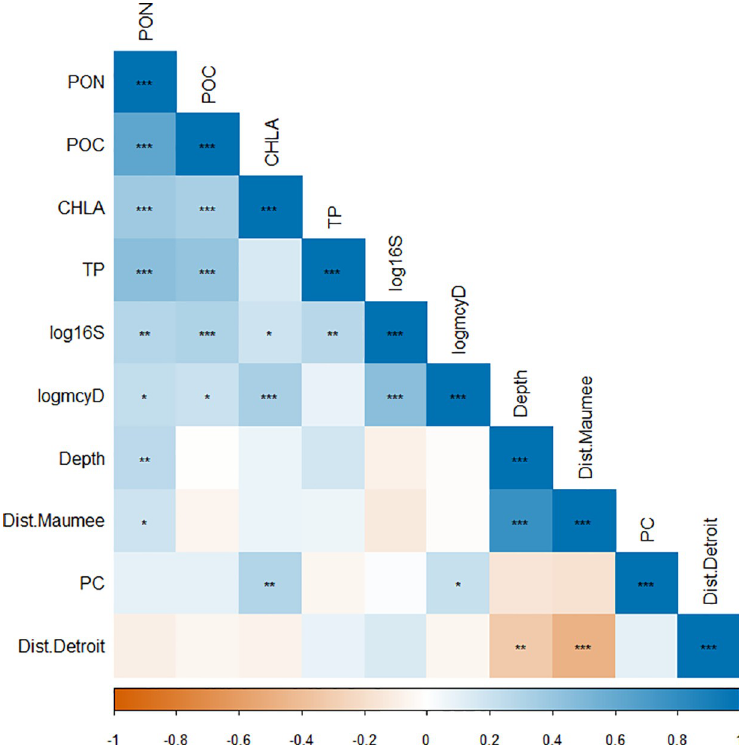
Fig 5. Correlation matrix of various parameters measured in the study. Values of correlation coefficients are indicated by color and statistical significance of correlations are indicated by symbol ( � : p < 0.05, �� : p < 0.01, ��� : p < 0.001). Both total Microcystis (cell equivalents g -1 ) and potentially-toxic Microcystis (cell equivalents g -1 ) were log- transformed. The strength of correlation coefficients were assessed based on Cohen’s standard (i.e. correlation coefficients between 0.10 and 0.29 represent a weak association, coefficients between 0.30 and 0.49 represent a moderate association, and coefficients of 0.50 and above represent a strong association).